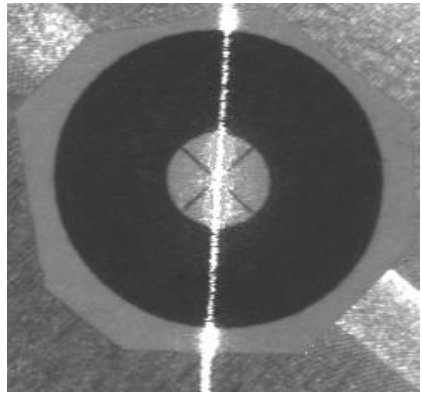
Figure 6. Alignment of the TCP with the fixed